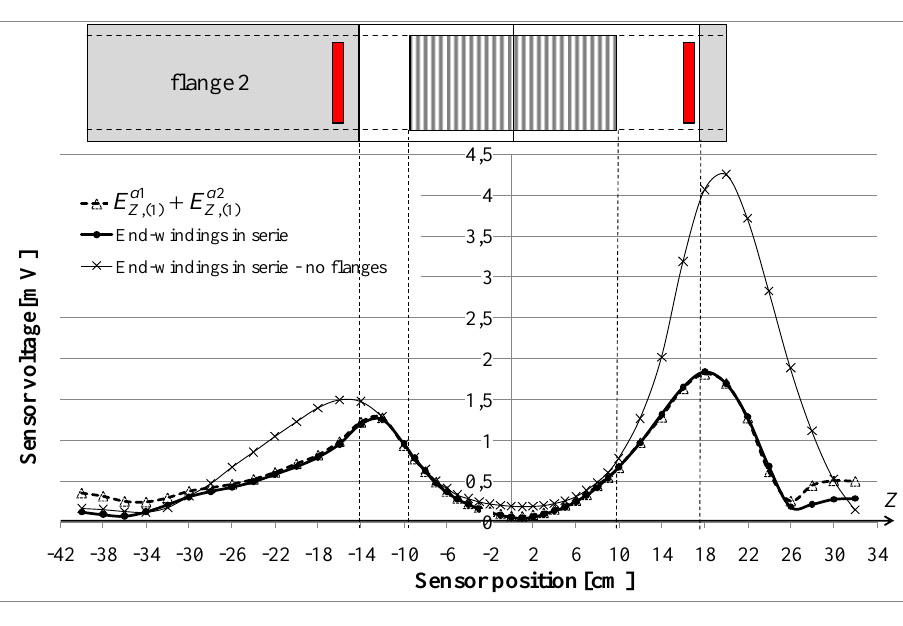
(b) End-windings connected in